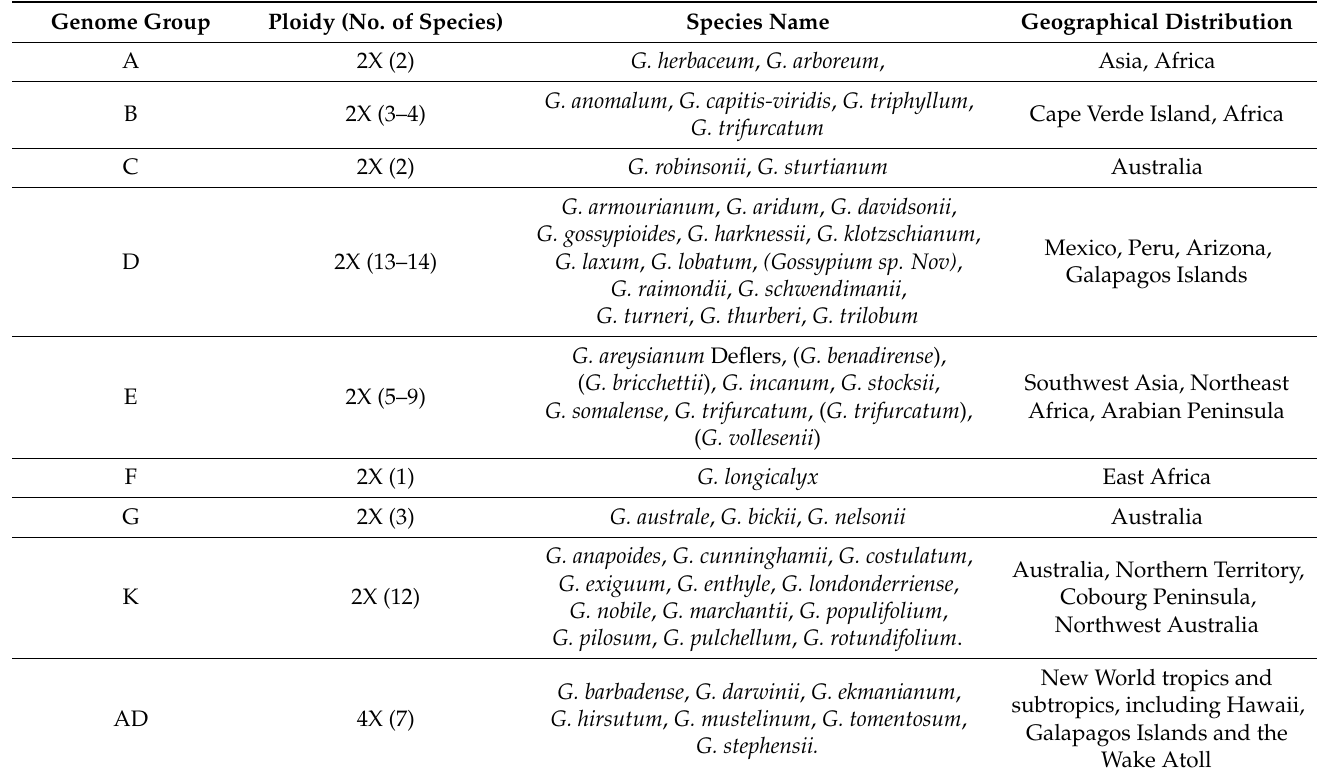
Table 1. Grouping and geographical distribution of the genus Gossypium species based on genomic diversity validated by cytogenetic data and other